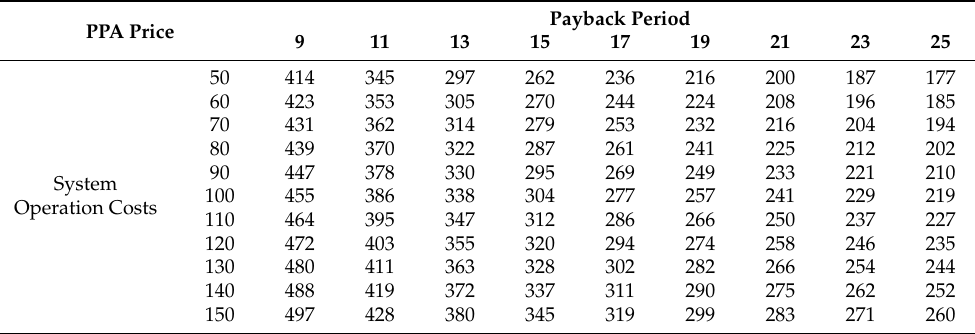
Table 3. Analysis of the Correlation between System Operation Costs, Investment Payback Period and PPA